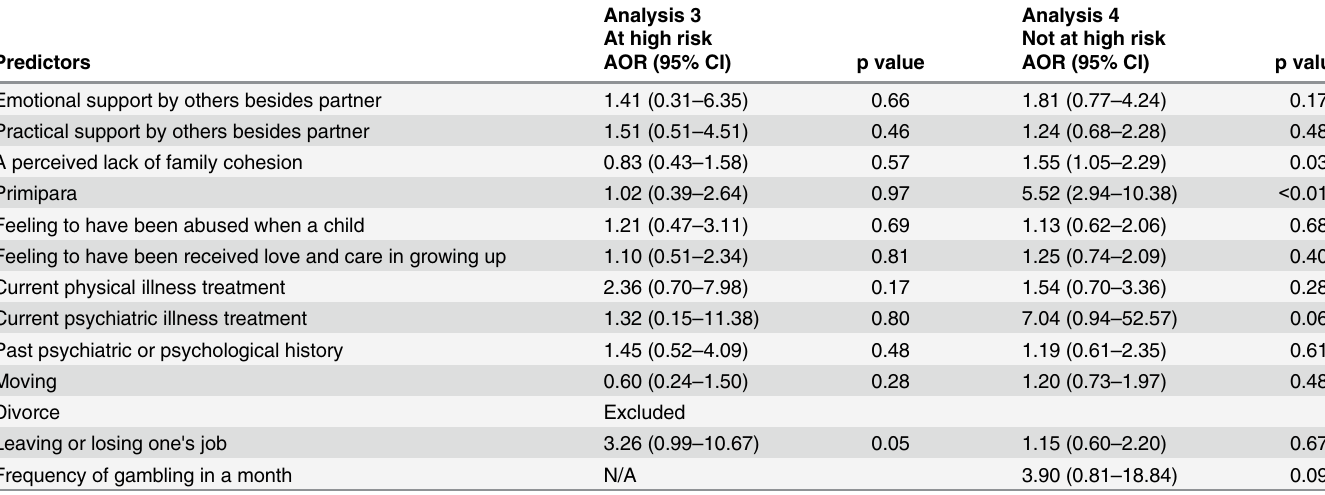
Table 6. Odds comparisons of woment at high risk and not at high risk of depression during